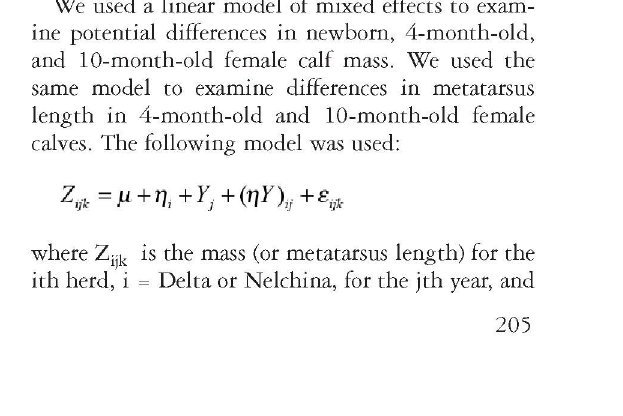
Table 2. Mean weights and standard deviations (s) in kg of female newborn, 4-month-old, and 10-month-old caribou calves in the Nelchina caribou herd.